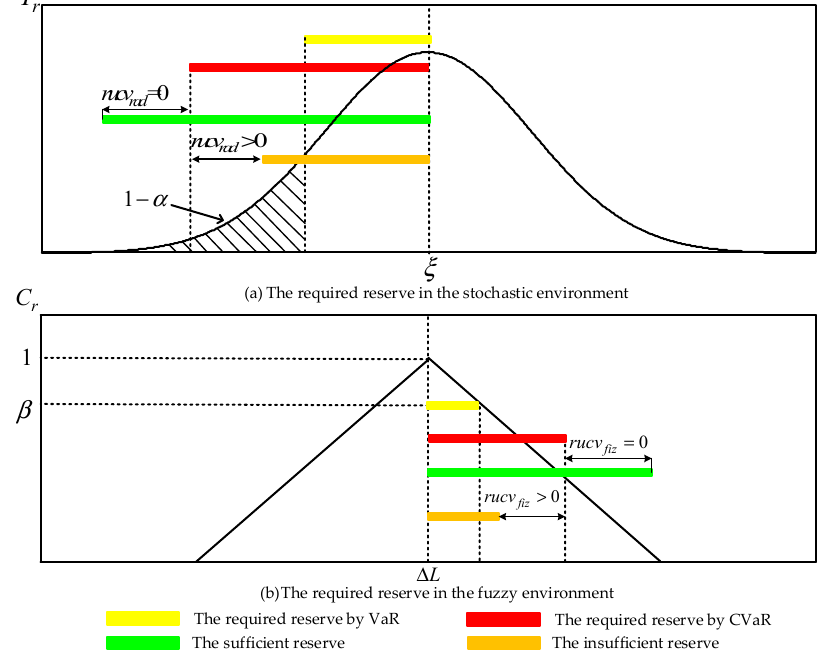
Figure 3. The physical meaning of the deviation variables.